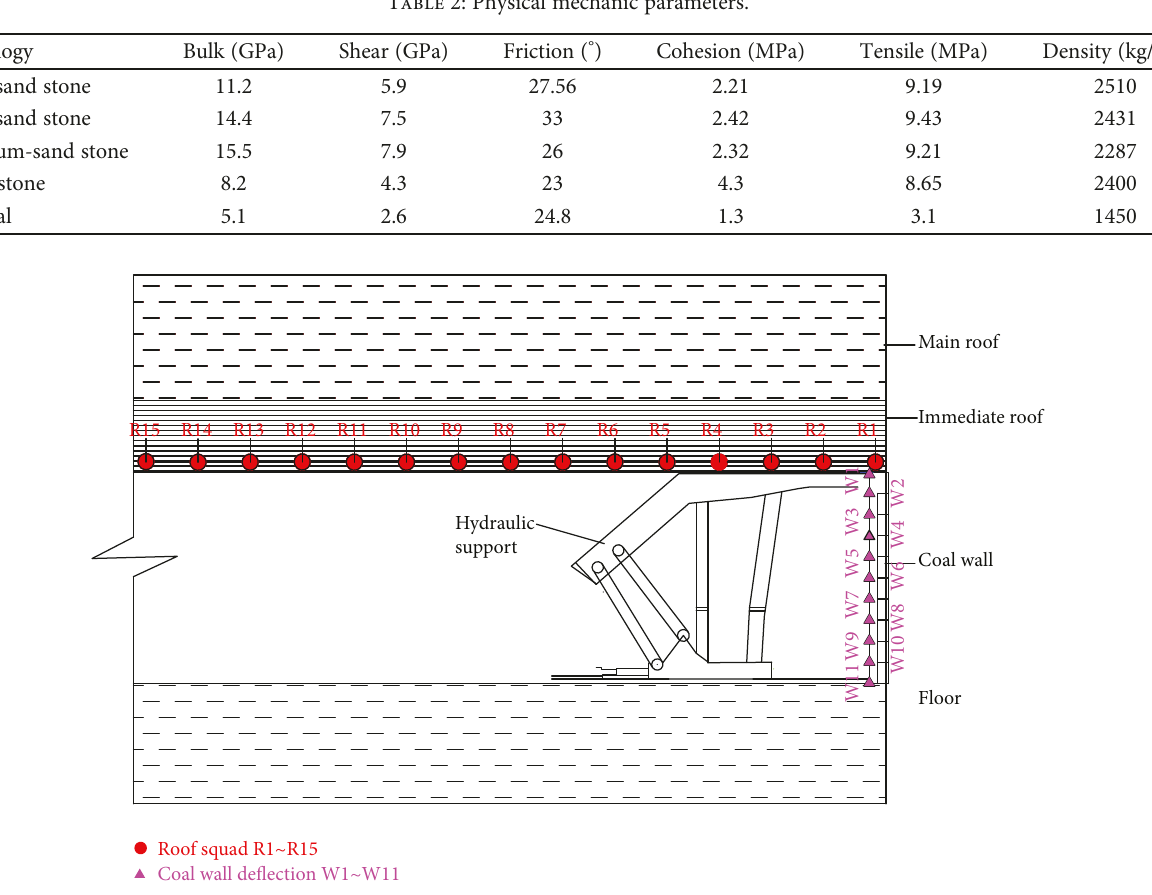
Figure 8: Monitoring